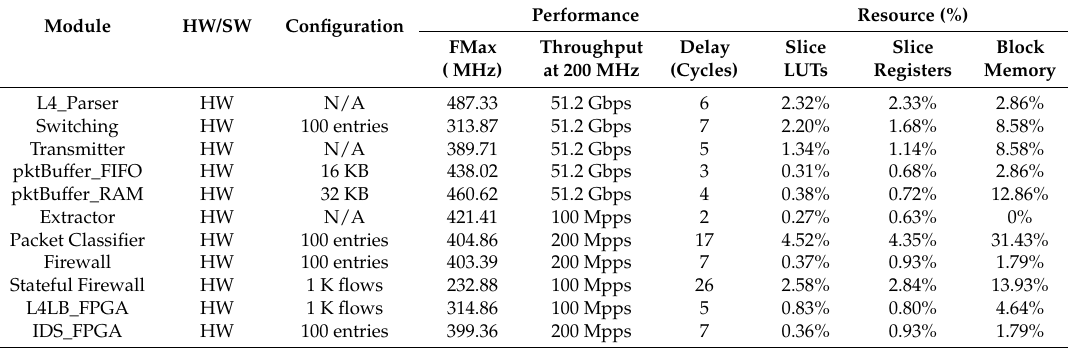
Table 2. Performance and resource consumption of key modules in DrawerPipe